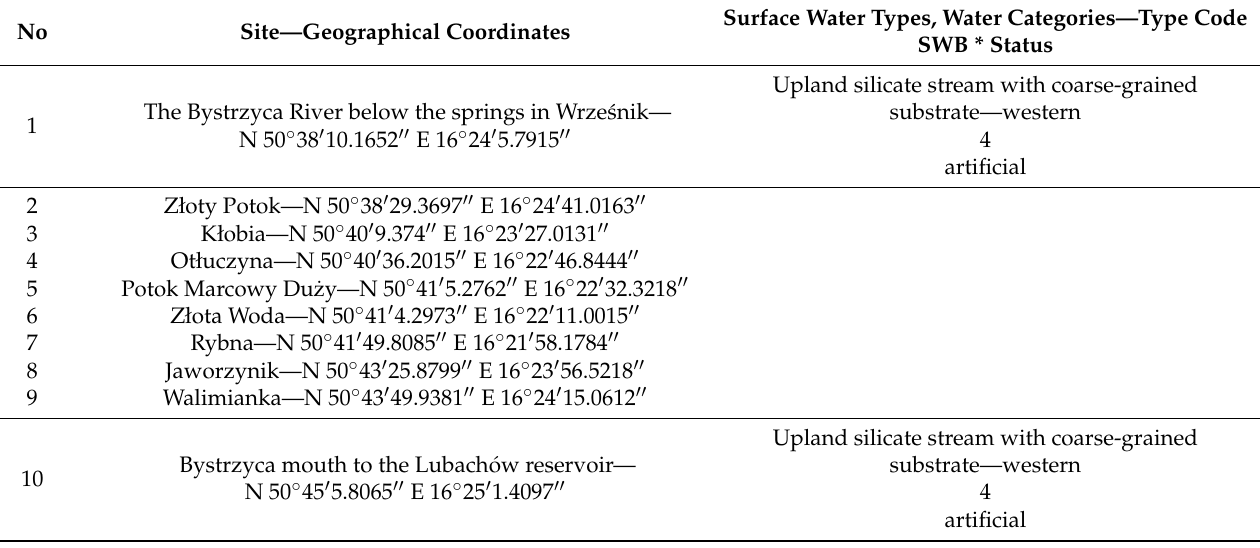
Table 4. Research sites—the Bystrzyca River and its tributaries above the Lubach ó w dam reservoir